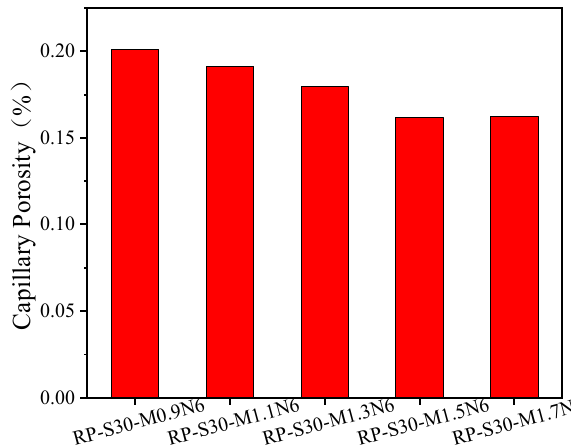
Figure 10. Capillary porosity of RPSG with different moduli.